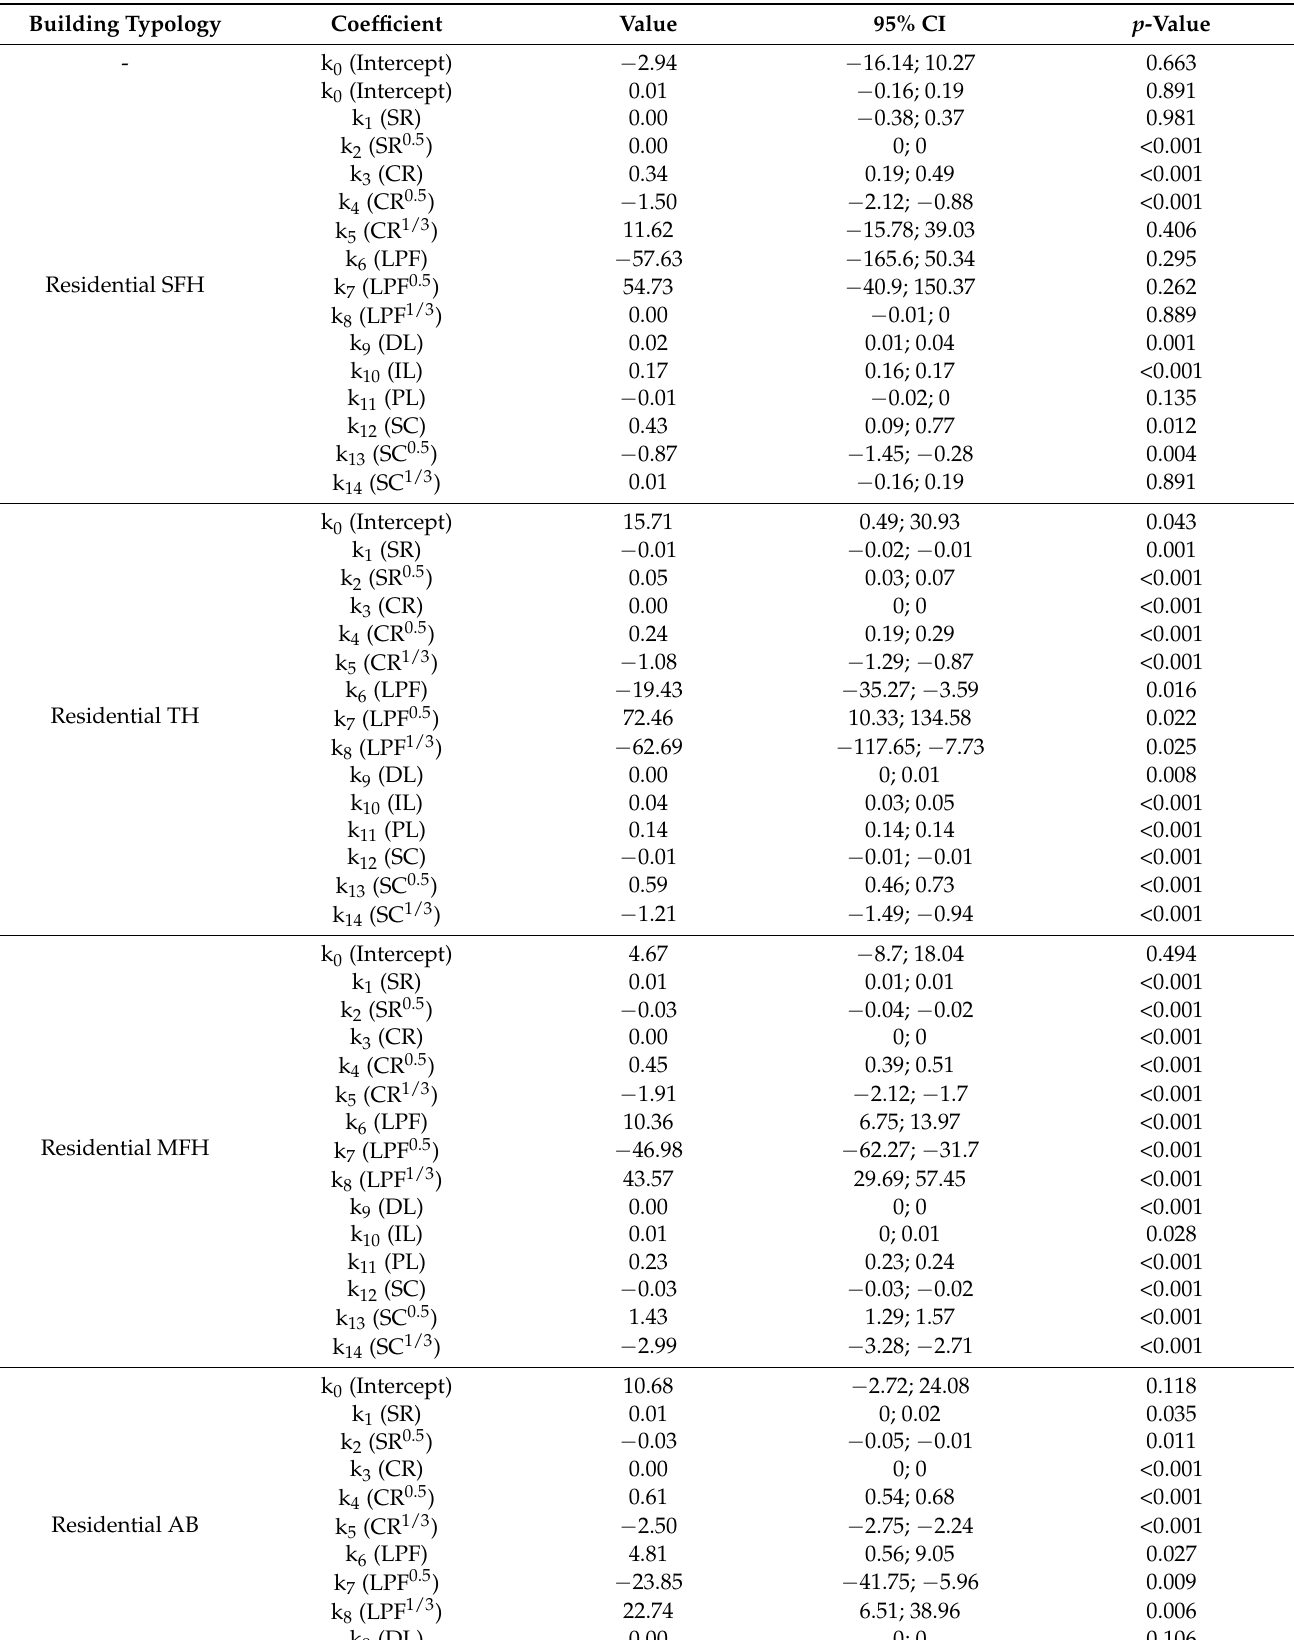
Table A3. QR coefficients to estimate IRR for each building